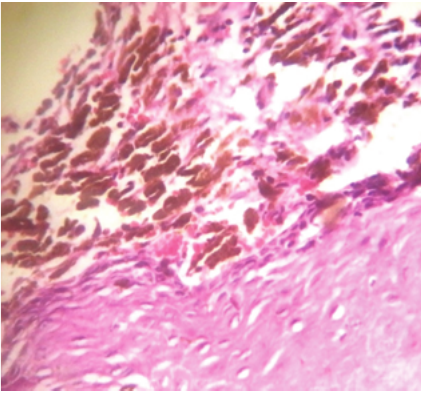
Figure5:CoronalCTscanshowingill-definedenhancingsofttissue mass on palate with bone destruction.